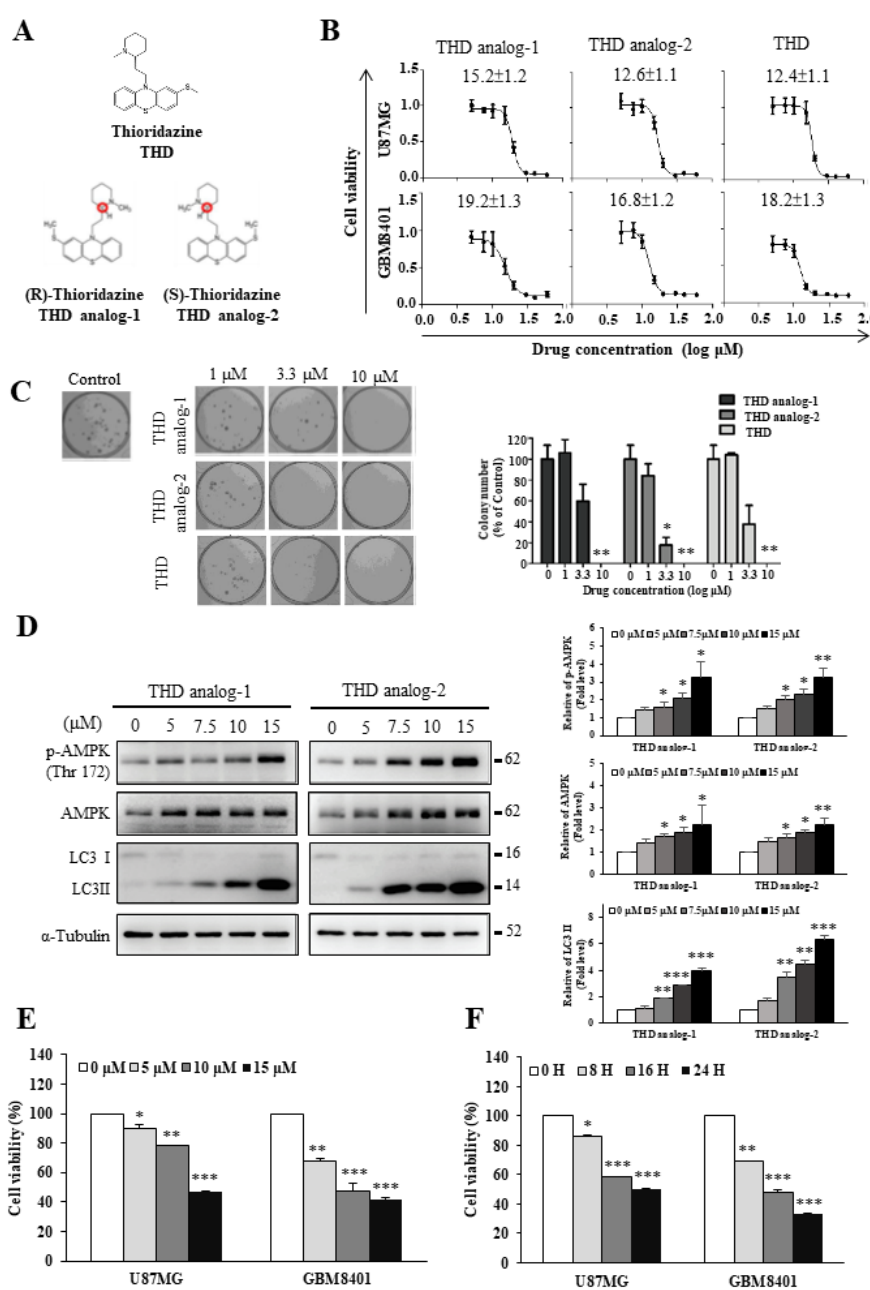
Figure 1. Thioridazine (THD) and THD analog treatments exerted an inhibitory effect on glioblastoma multiform (GBM) cells. ( A ) Structure of THD and enantiomers of the THD analog; ( B ) Cell viability was assessed in GBM8401 and U87MG cells by using the sulforhodamine B (SRB) assay. After 24 h drug treatments, the IC 50 values of drugs were calculated using GraphPad Prism (THD analog-1 and analog-2 are racemic compounds). A summary of IC 50 values is provided in the table; ( C ) Clonogenic assays were performed to assess the effect of THD and THD analogs on colony formation in GBM8401 cells. The IC 50 values of all drugs were less than 10 µ M; ( D ) GBM8401 cells were treated with different analogs of THD at 5, 7.5, 10, and 15 µ M for 24 h separately. p-AMPK (Thr172), AMPK, LC3I, and LC3-II were detected using Western blotting. α -Tubulin was used as an internal control; ( E ) THD suppressed the proliferation of glioma cell lines. U87MG and GBM8401 cells were treated with various concentrations of THD for 24 h; ( F ) Cells were incubated for 8, 16, and 24 h in the presence of THD (15 µ M), after which cell viability was assessed using CCK-8 assays. Bar graphs represent the mean of triplicates ± SD. * p < 0.05, ** p < 0.01, *** p < 0.001 compared with the control